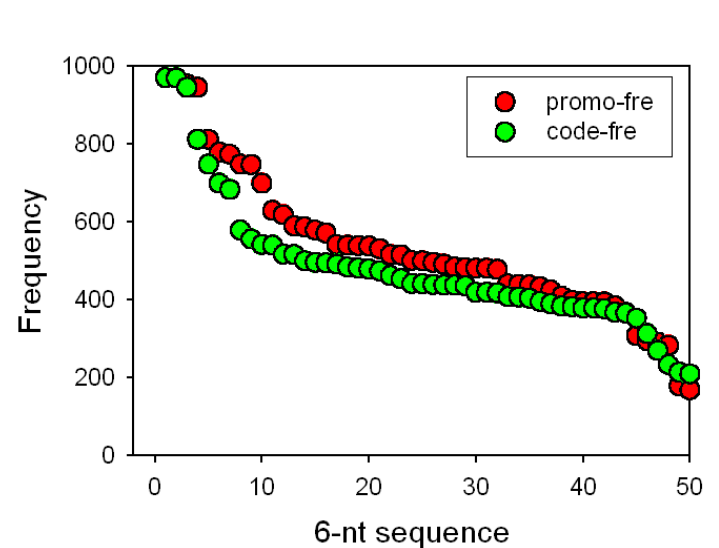
Figure 2: The frequencies of the 50 most common 6-nt sequences plotted after arranging the frequencies on a decreasing scale. The 6-nt sequences for the promoter side and the coding side are not necessarily identical and the x-axis represents simple ordinality. The actual sequences corresponding to these frequencies are given in the “additional material” section. The graph shows typical “sigmoidal” shape suggesting some internal cooperative